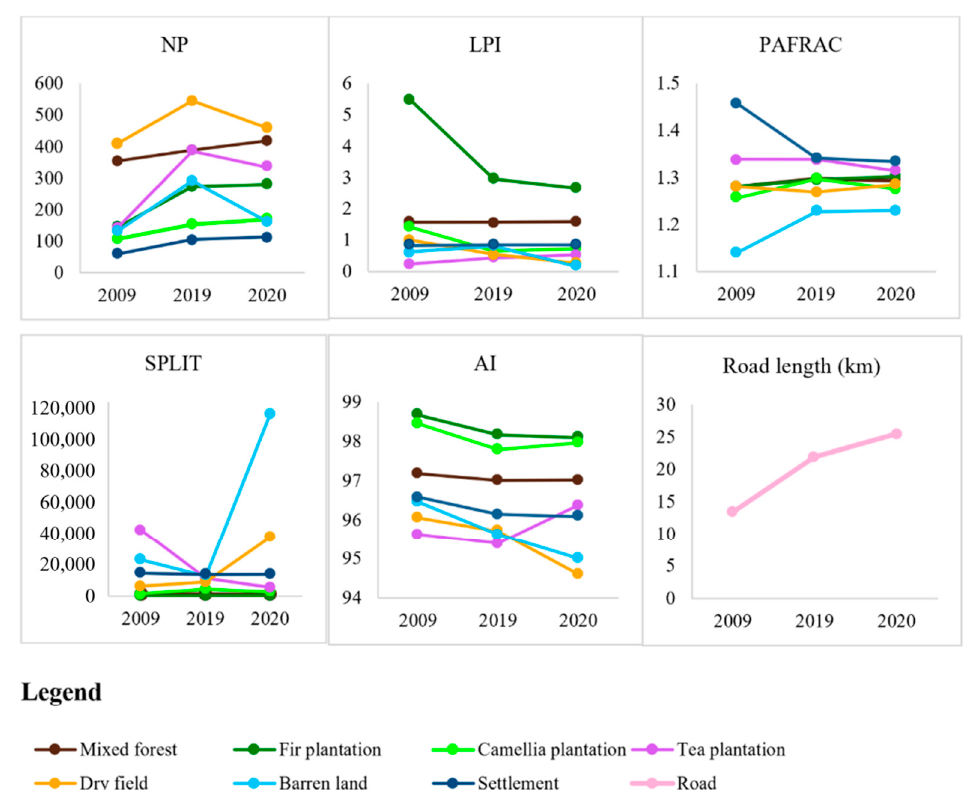
Figure 7. Changes in landscape metrics at class level. NP: number of patches; LPI: largest patch